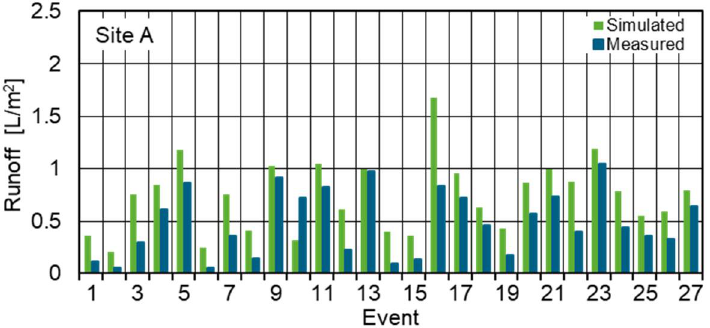
Figure A8. Measured and simulated façade runoff of buildings at test site A and site B for 27 and 26 events, respectively. Events with more than 10 mm rainfall were taken into account as a basis for the prediction.